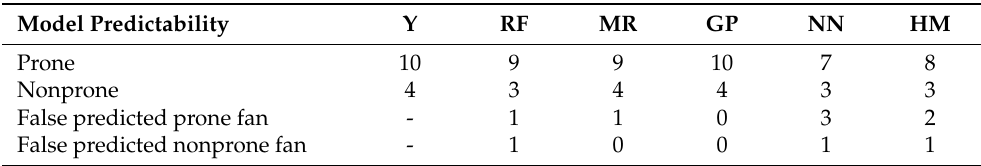
Figure 12. Experimental (Y) and prediction data (RF, MR, GP, NN, and HM). Table 5. Comparison of the successfulness of the 5 machine learning models in relation to the experimental Bertrand value